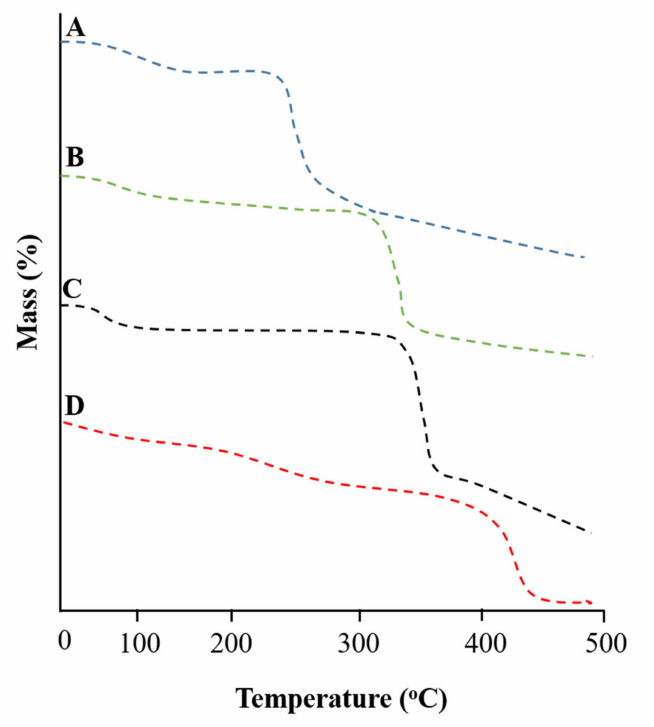
Figure 4. TGA thermogram of ( A ) acyclovir, ( B ) tamarind gum powder, ( C ) β -cyclodextrin, and ( D ) the developed network